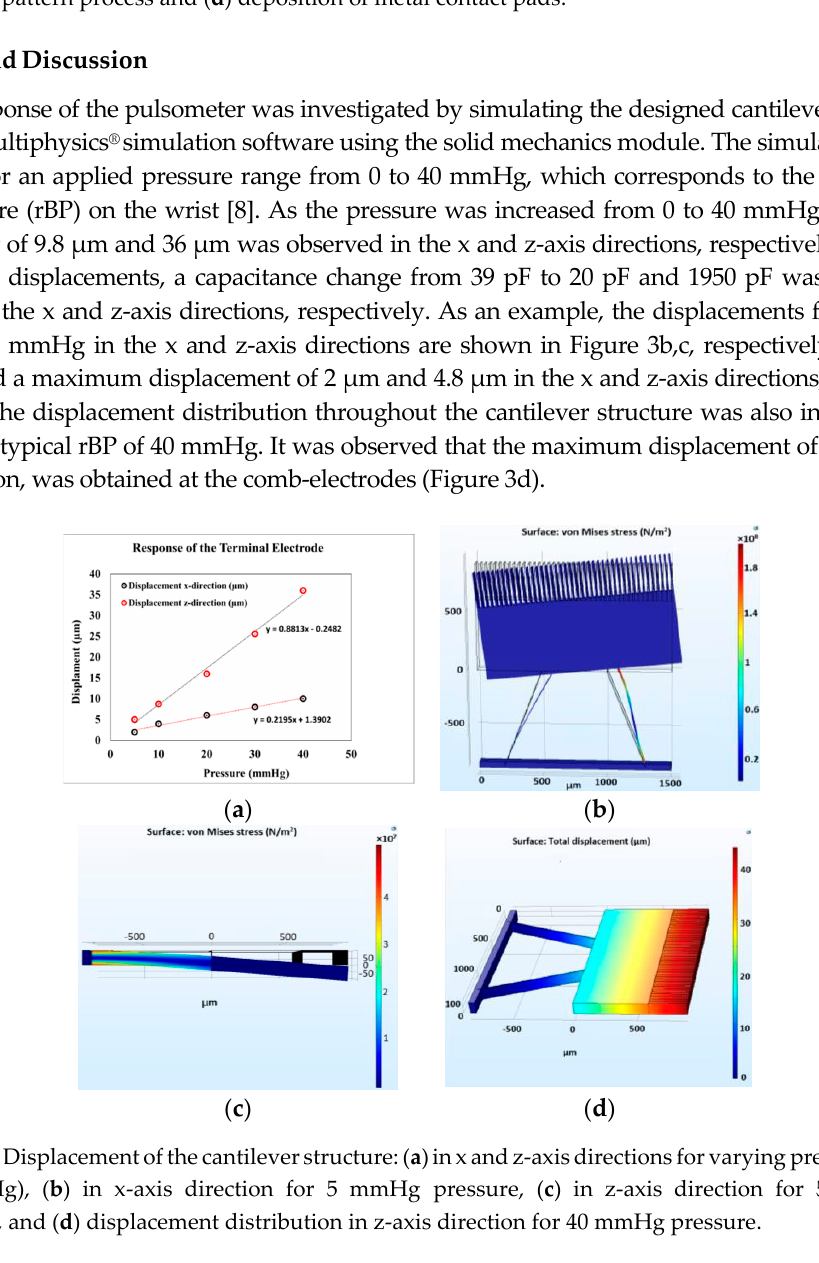
Figure 2. ( a ) Etching glass to form recess, ( b ) anodic bonding of the glass substrate and silicon wafer, ( c ) DRIE pattern process and ( d ) deposition of metal contact pads.